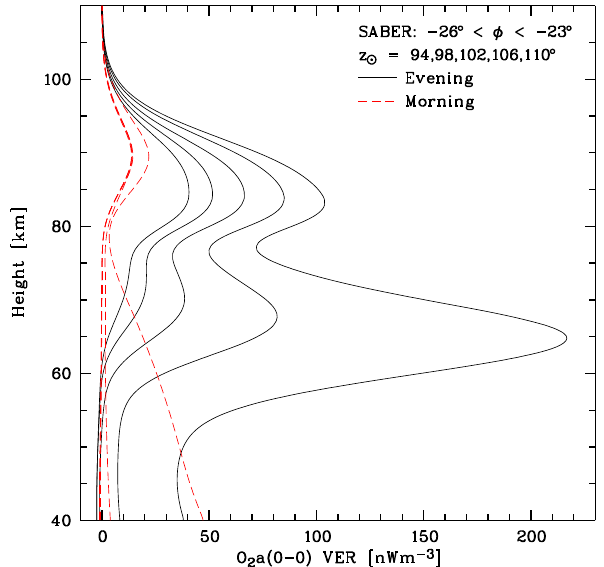
Figure 1. Average SABER volume emission rate profiles of O 2 a (0- 0) during evening (solid lines) and morning twilight (dashed lines) for the latitude range from 23 to 26 ◦ S and the years from 2009 to 2013. The plot shows profiles for five different solar zenith distances z (cid:12) from 94 to 110 ◦ . The VERs decrease with increasing z (cid:12) .